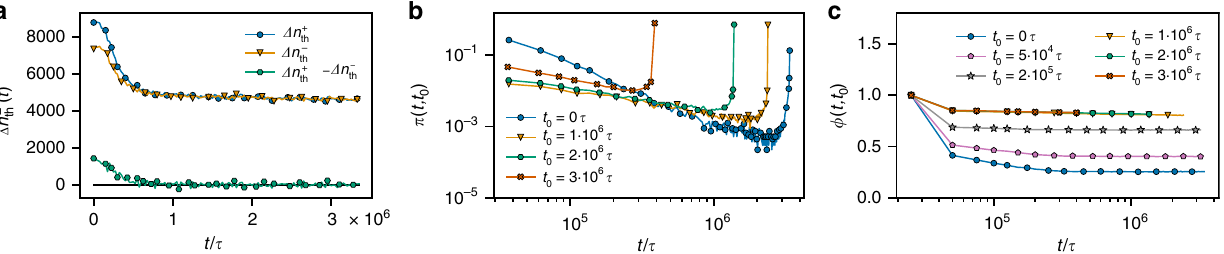
(cid:2) Δ n (cid:2) as a function of time th th